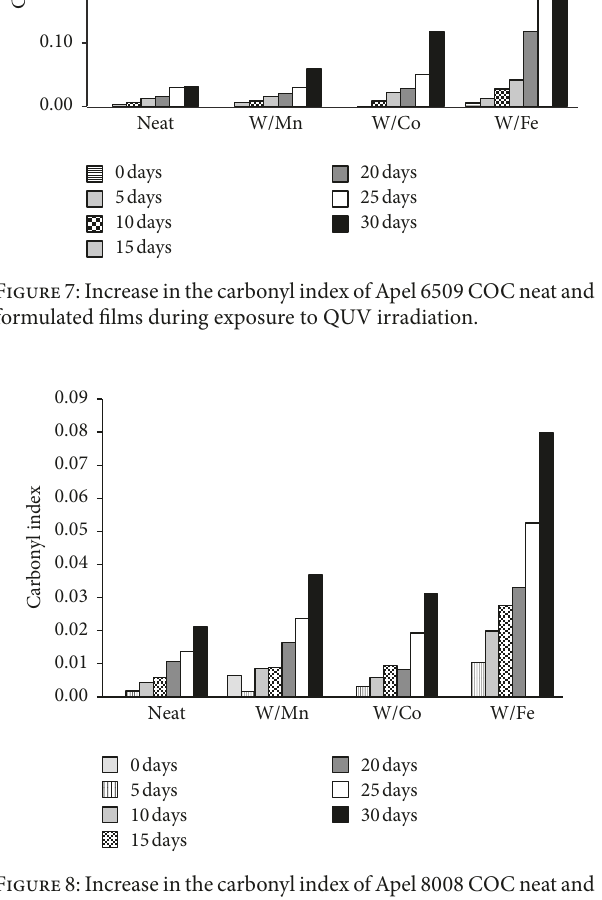
Figure 8: Increase in the carbonyl index of Apel 8008 COC neat and formulated films during exposure to QUV irradiation.